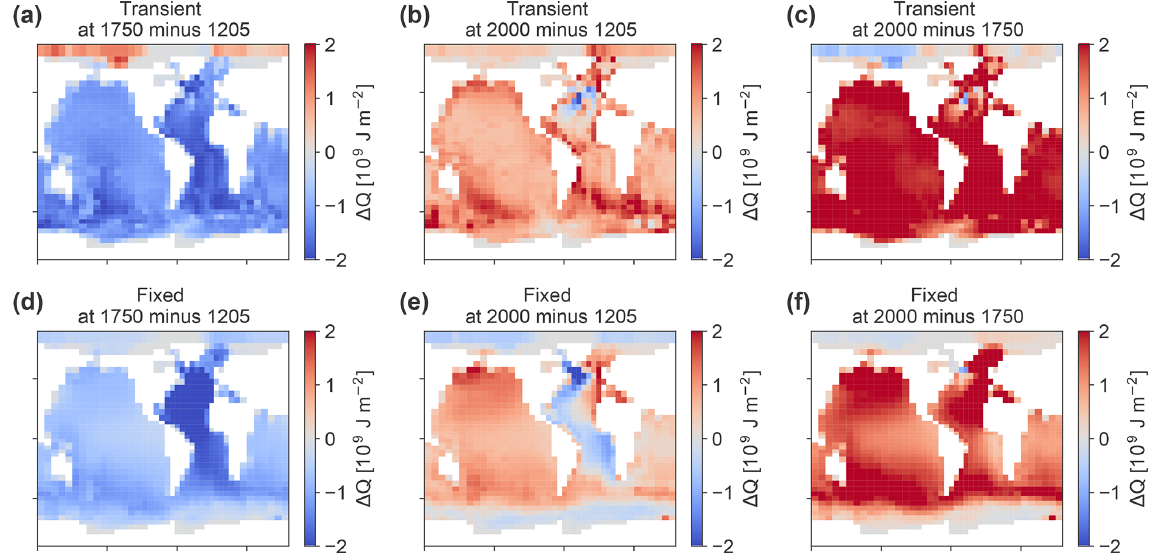
Figure 6. Ocean heat areal density (OHD) anomalies for transient and fixed circulation. (a, b) Anomalies in 1750 and 2000CE, both with respect to the year 1205 for case OcTRA and (d, e) for case OcFIX. (c, f) Anomalies in 2000CE are also shown with respect to year